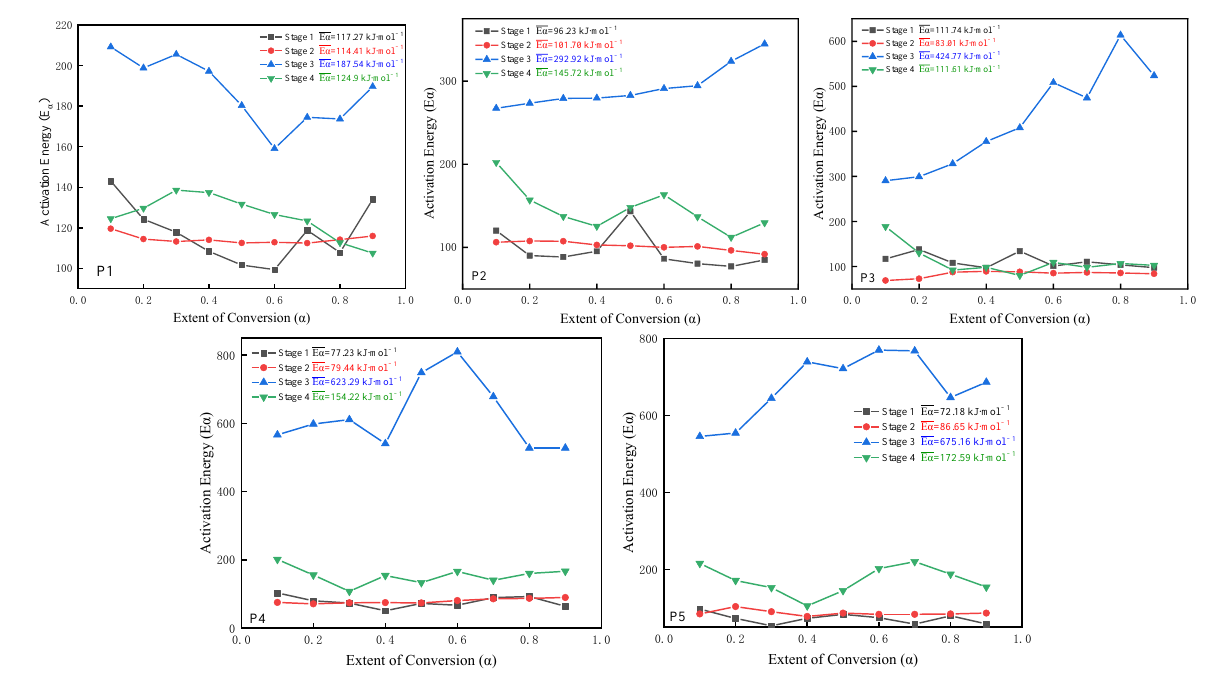
Figure 13. Activation energy curve of Samples P1 – P5 at each stage obtained via the Flynn – Wall – Ozawa method.